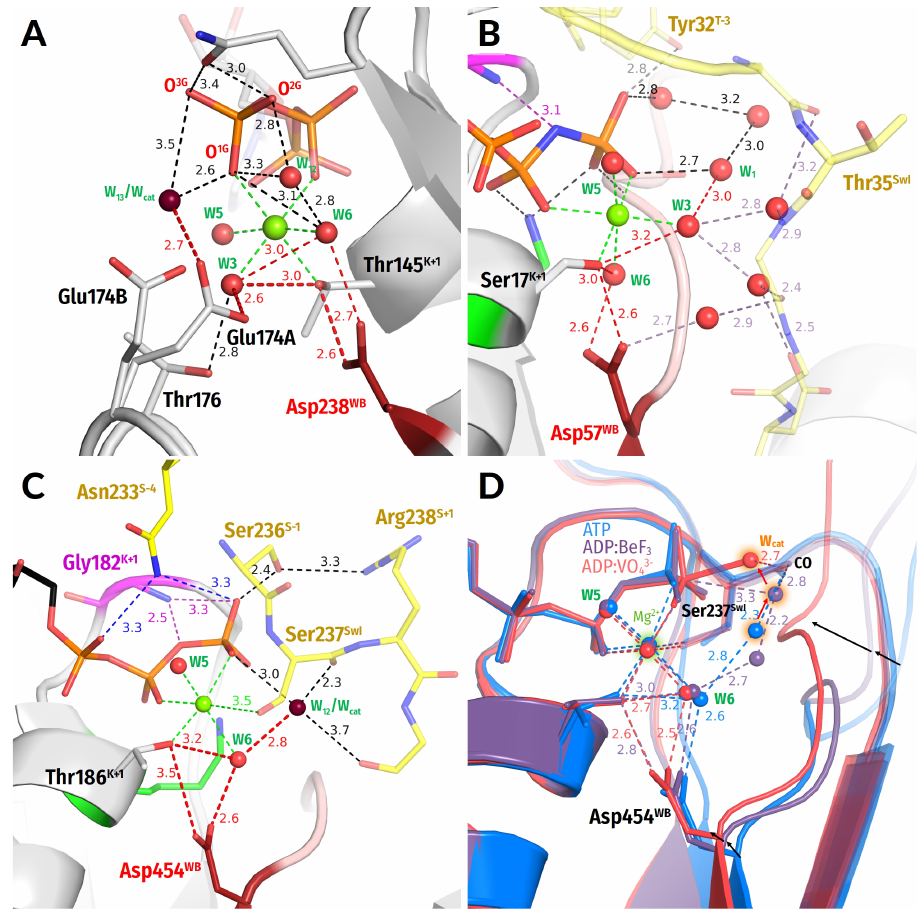
Figure 7. Networks of water molecules in the catalytic sites of P-loop NTPases . ( A ) ATP-soaked ATPase domain of RadA from Pyrococcus furiosus (PDB ID 4A6X, [136]). ( B ) Human H-Ras GTPase (PDB ID 5B30 [137]). ( C ) ATP-soaked Myosin II from Dictyostelium discoideum (PDB ID 1FMW, [140]). Colour code as in Figures 1E,F and 3–6. ( D ) Three overlapped crystal structures of myosin II from Dictyostelium discoideum, the same as in panel 7( C ); blue, ATP-soaked structure (PDB ID 1FMW, [140]); violet, ADP:BeF 3 -containing structure (PDB ID 1W9K); red, ADP—VO 43 − -containing, TS-like struc- ture (PDB ID 1VOM [93]); the would-be W cat water molecules are surrounded by orange halos.